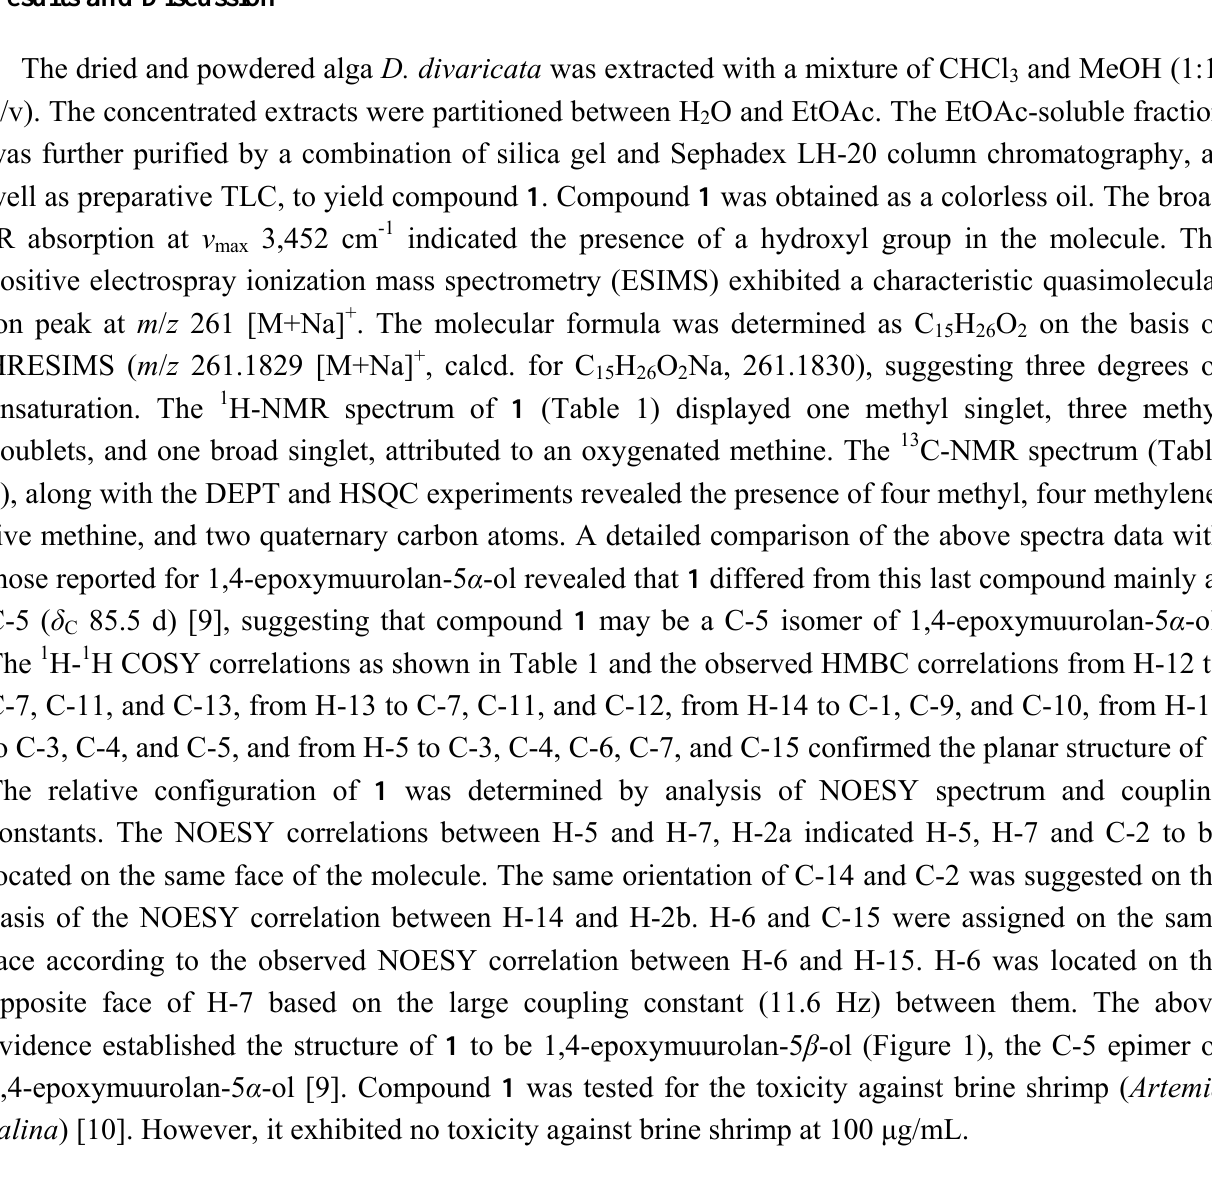
Figure 1. Structure of compound 1